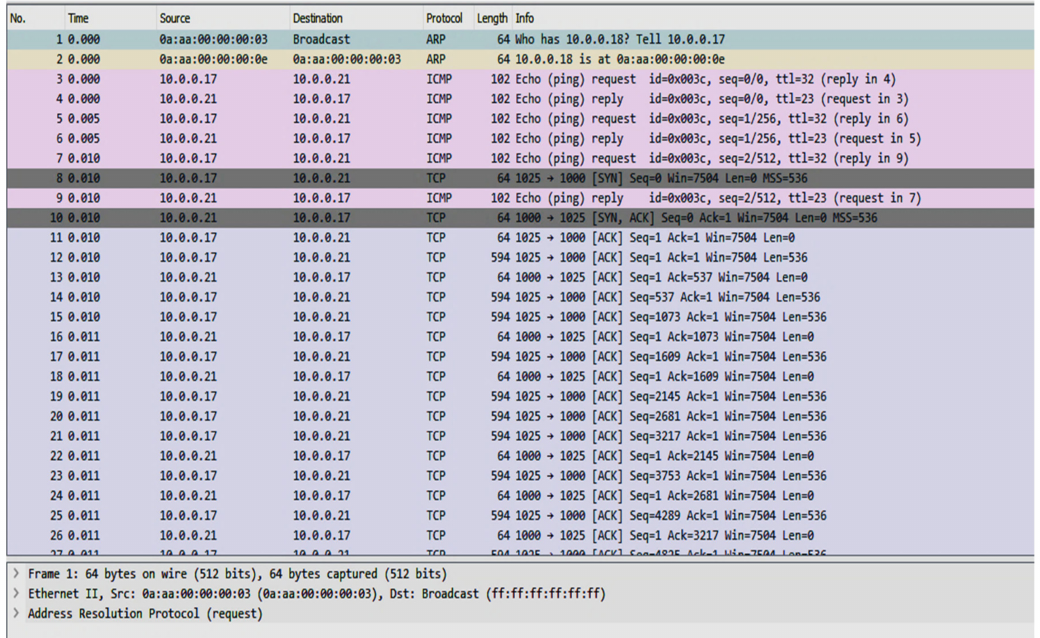
Figure 8. The packet flow for Transmission Control Protocol (TCP) in the microgrid